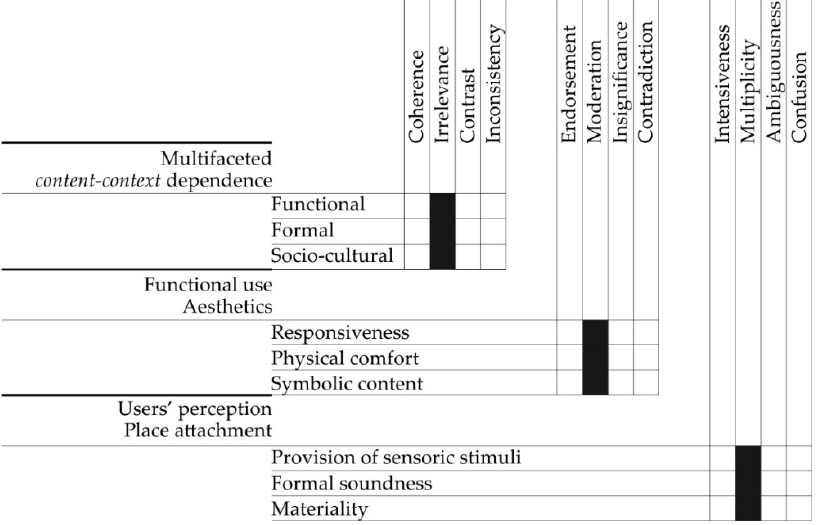
Figure 8. The qualitative evaluation of the area relation, determined in function to the application of building techniques, within main criteria group. Case study: Main entrance area, Museum of the History of Polish Jews, POLIN, Warsaw.